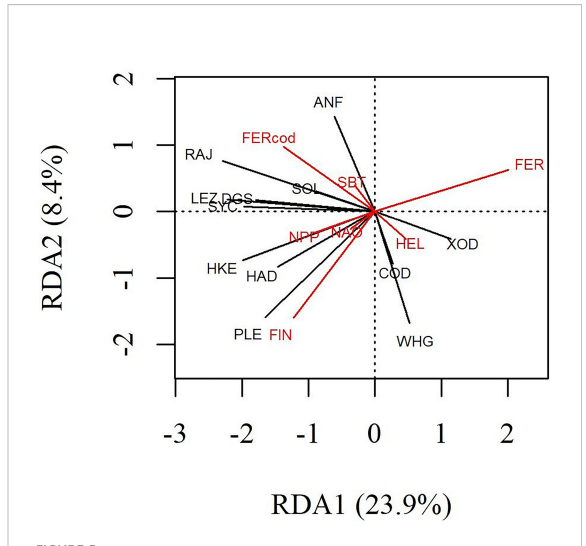
FIGURE 5 RDA correlation triplot of CPUE series (black) constrained by explanatory variables (red). The direction and orthogonality between vectors and ordination axes indicate the direction and strength of the linear